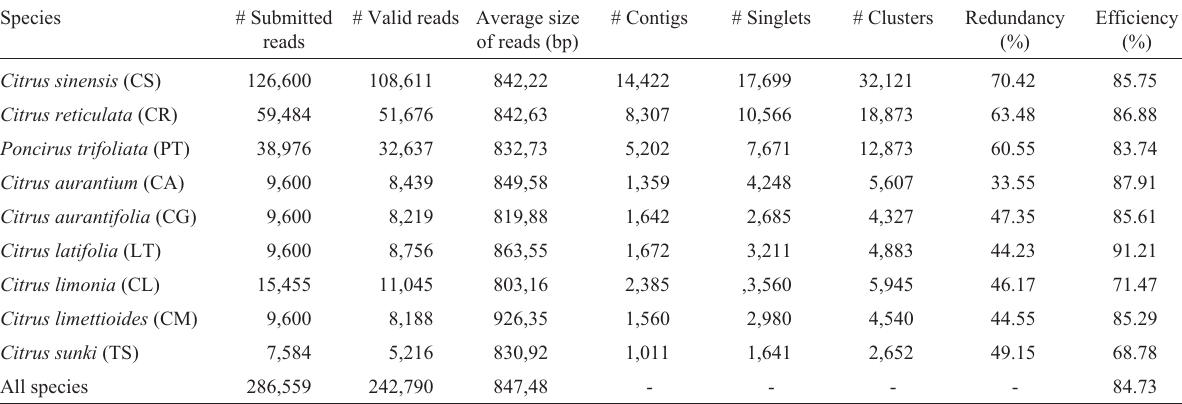
Table 3 - Summary of CitEST